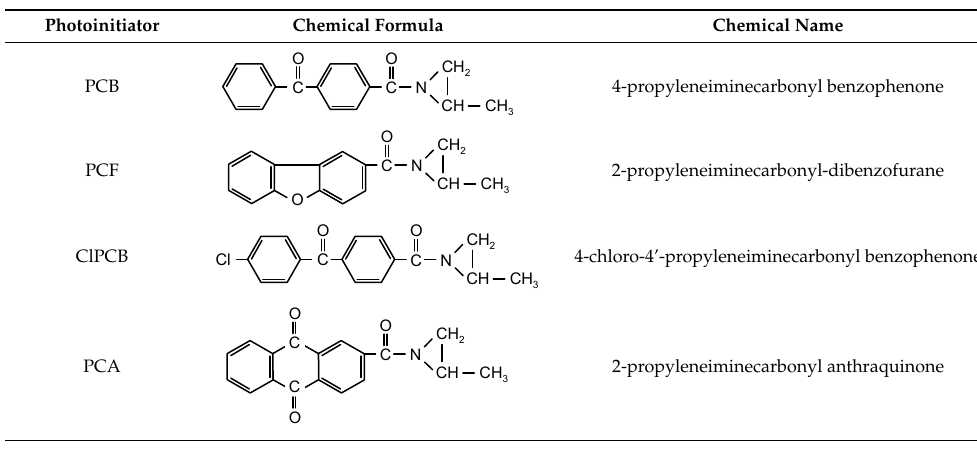
Table 1. The photoinitiators under Table 1. The photoinitiators under study. Table 1. The photoinitiators under study. Table 1. The photoinitiators under study. Table 1. The photoinitiators under study.